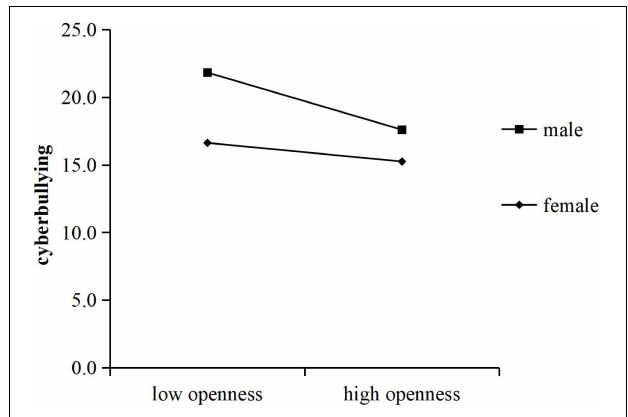
FIGURE 3 | The moderating effect of gender on openness and